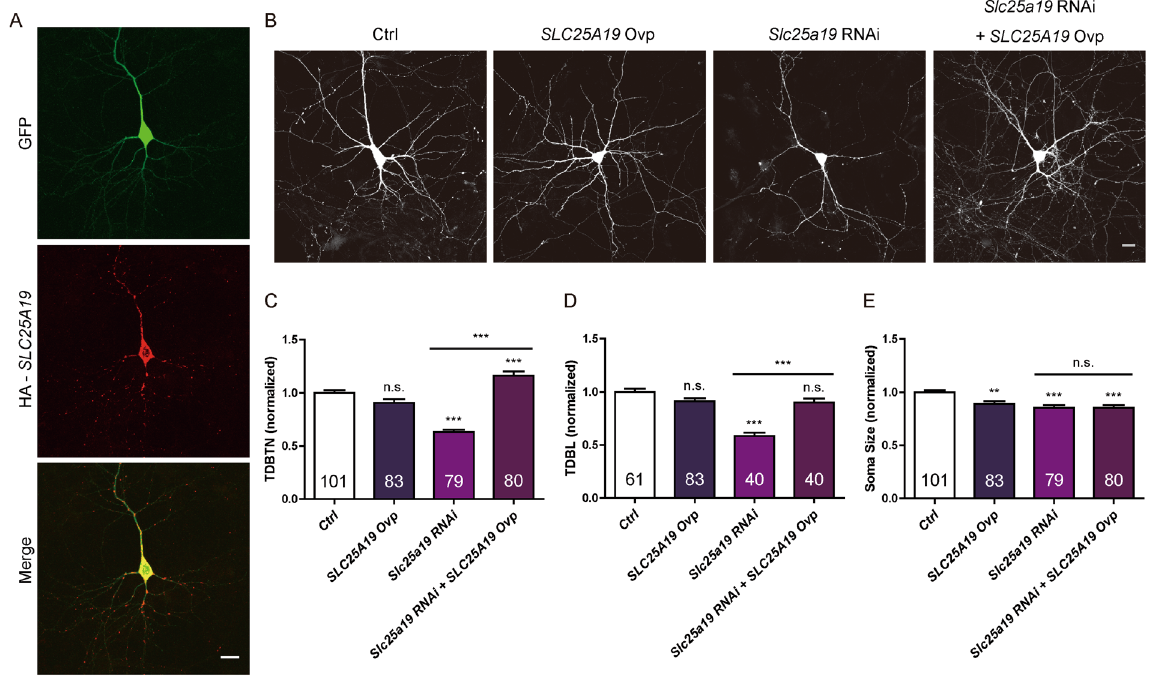
Figure 4. Overexpression of human SLC25A19 significantly rescued the reduction of TDBTN and TDBL induced by Slc25a19 RNAi. ( A ) Immuostaining of DIV11 neuron transfected with GFP and HA- SLC25A19 constructs. ( B ) Representative images of DIV10 neurons, conditions as indicated. ( C ) Quantitation of TDBTN: Ctrl (1.00 ± 0.02), SLC25A19 Ovp (0.91 ± 0.03, n.s. vs Ctrl), Slc25a19 RNAi (0.63 ± 0.02, P < 0.001 vs Ctrl), Slc25a19 RNAi + SLC25A19 Ovp (1.16 ± 0.04, P < 0.001 vs Ctrl, P < 0.001 vs Slc25a19 RNAi). ( D ) Quantitation of TDBL: Ctrl (1.00 ± 0.03), SLC25A19 Ovp (0.91 ± 0.03, n.s. vs Ctrl), Slc25a19 RNAi (0.58 ± 0.03, P < 0.001 vs Ctrl), Slc25a19 RNAi + SLC25A19 Ovp (0.90 ± 0.04, n.s. vs Ctrl, P < 0.001 vs Slc25a19 RNAi). ( E ) Quantitation of soma size: Ctrl (1.00 ± 0.02), SLC25A19 Ovp (0.89 ± 0.03, P < 0.01 vs Ctrl), Slc25a19 RNAi (0.85 ± 0.03, P < 0.001 vs Ctrl), Slc25a19 RNAi + SLC25A19 Ovp (0.85 ± 0.02, P < 0.001 vs Ctrl, n.s. vs Slc25a19 RNAi).